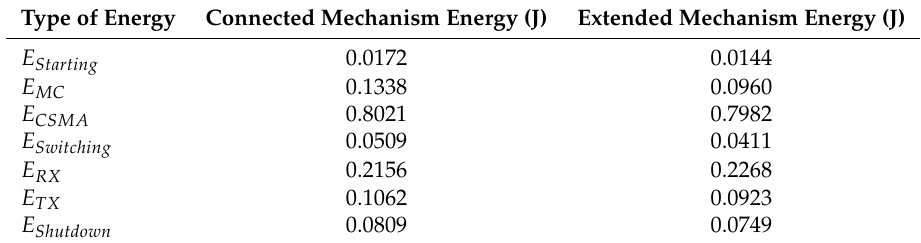
Table 4. Energy consumption for each detection